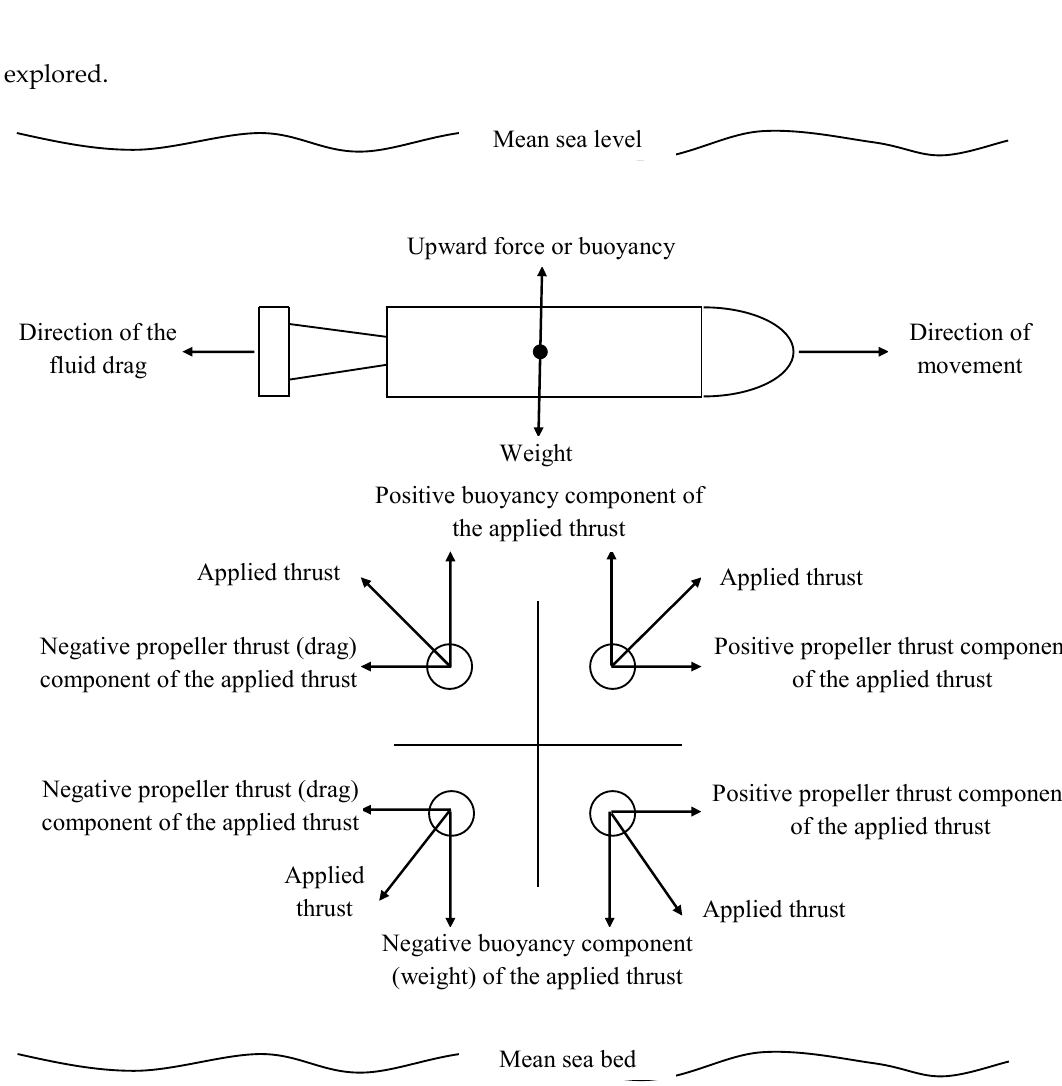
Figure 1. Schematic diagram to illustrate the buoyancy control with applied thrust.